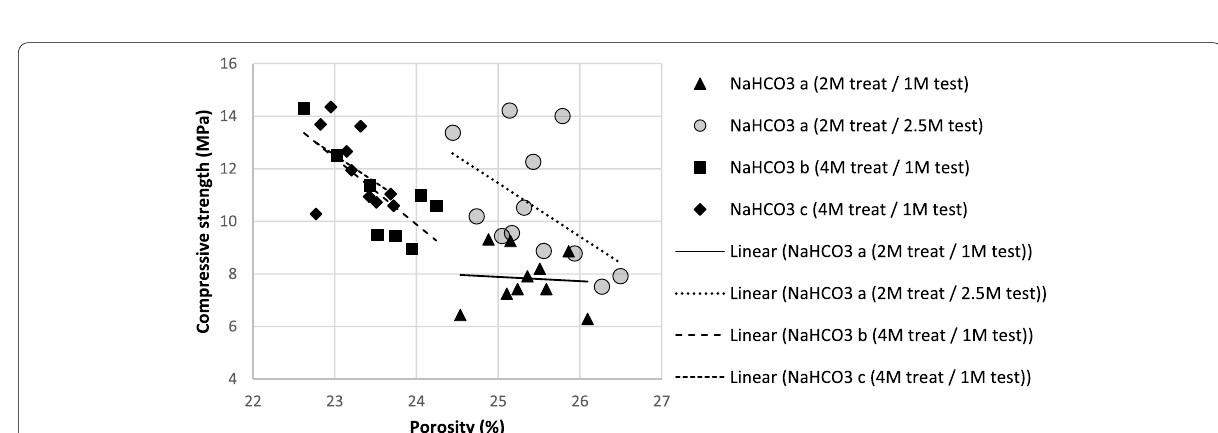
Fig. 2 Compressive strength versus porosity: NaHCO 3 treated specimens, segregated by Batch (“X M treat” test” tested Y months after treatment =